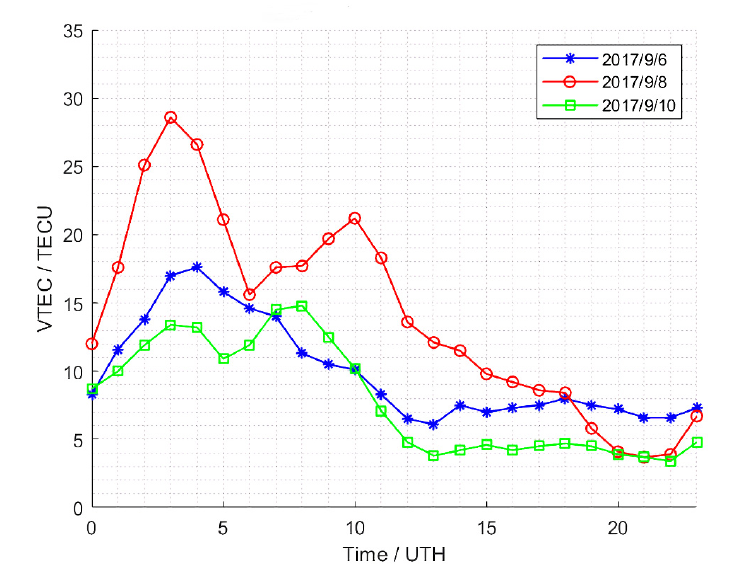
Figure 4. VTEC time series of grid point 2 (22.5° S–110° E). Same as Figure 3, the blue, red, and green polylines represent the fluctuation trend of VTEC pre-, mid- and post-geomagnetic storm phases, respectively, unit: TECU.